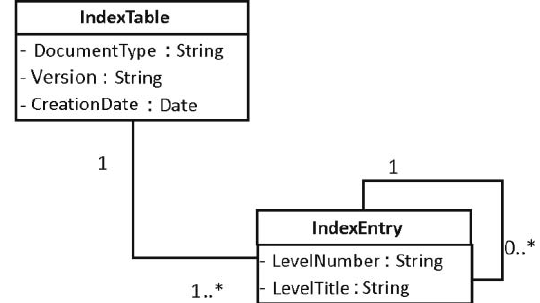
Fig. 4. Data Model of Index